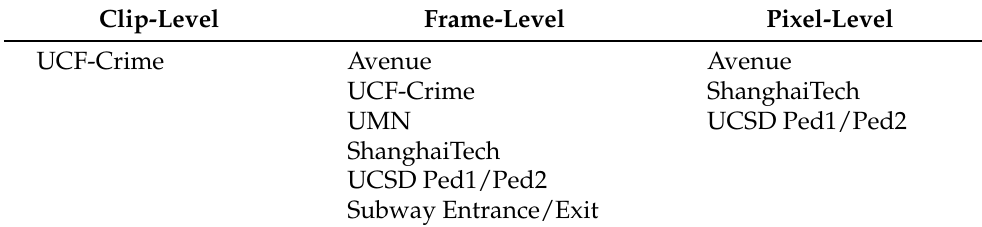
Table 13. Based on ground truth labeling.